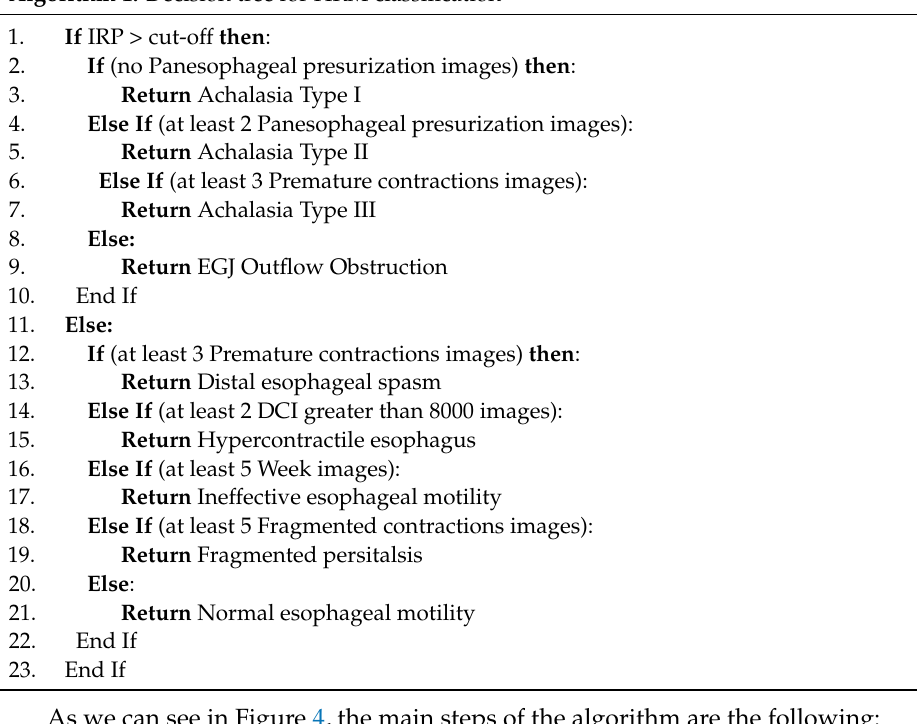
Algorithm 1: Decision tree for HRM